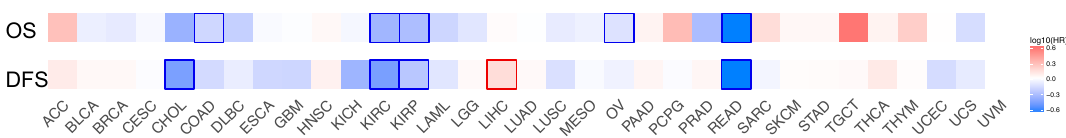
Figure A2. Survival analysis of LRRC19 in 33 cancer types of TCGA. Heat map of log based on gene expression and survival time performed by GEPIA2. We selected 50% as the suitable expression threshold for splitting the high-expression and low-expression cohorts. The hazards ratio (HR) was calculated based on Cox PH Model, and the HR value was scaled in decibel (dB). The red and blue color presented poor and good prognosis, respectively, and the intensity of color indicated the value of HR. The bounding box around the tiles represented the statistical significance of LRRC19 in the cancer of the Axis Units ( p < 0.05). From the results, LRRC19 was showed for its prognostic value in Cholangiocarcinoma (CHOL), Colon Adenocarcinoma (COAD), Kidney Renal Clear Cell Carcinoma (KIRC), Kidney Renal Papillary Cell Carcinoma (KIRP), Liver Hepatocellular Carcinoma (LIHC), Lung Adenocarcinoma (LUAD), Ovarian Serous Cystadenocarcinoma (OV), Rectum Adenocarcinoma (READ). Hazard ratios (HR), Overall survival (OS), Disease-free survival (DFS). The dot plot in Figure A3 shows the gene expression of LRRC19 in pan-cancer.